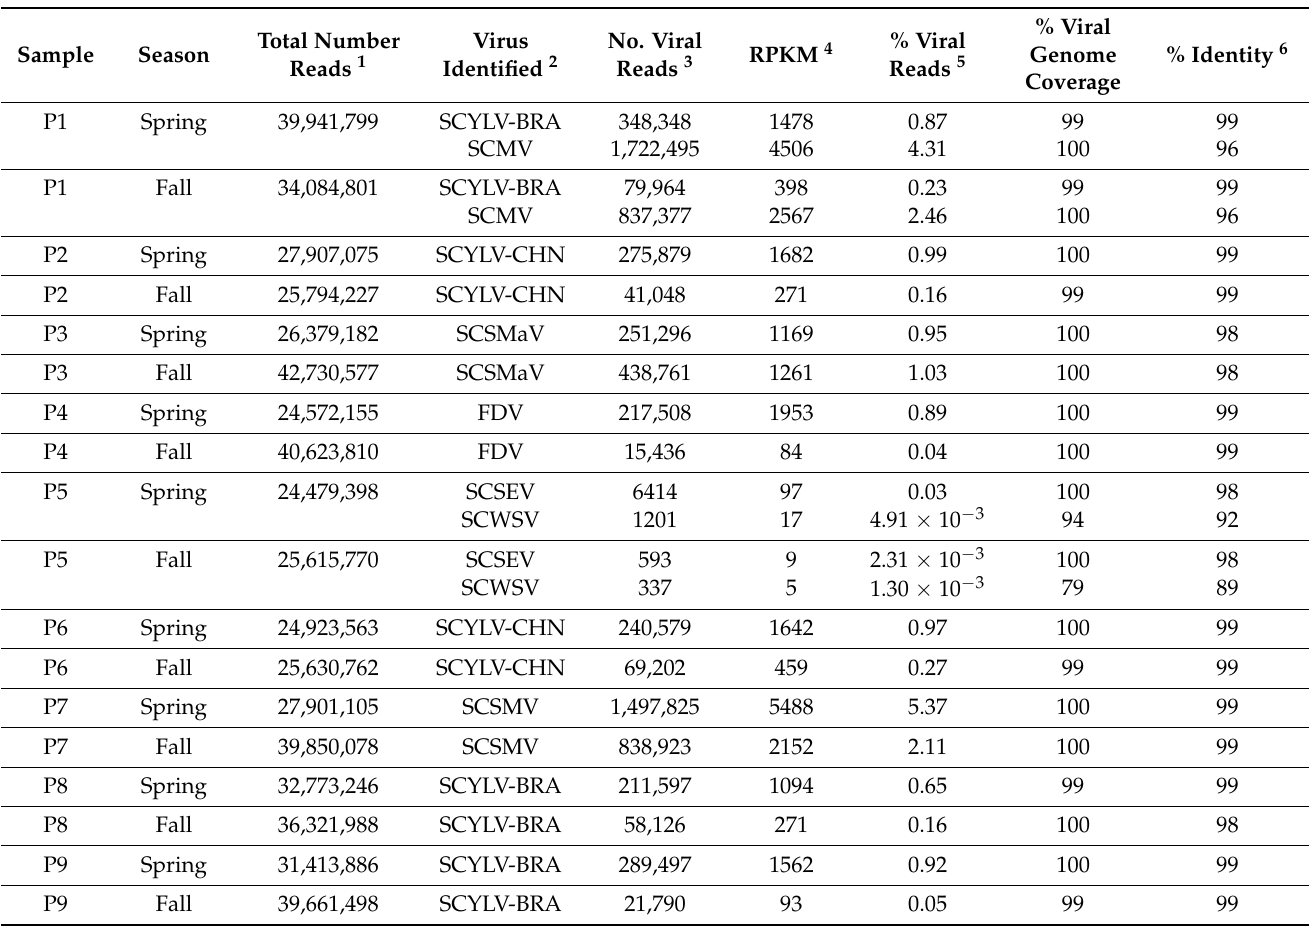
Table 3. Summary of sequencing and mapping statistics from HTS data generated for the nine sugarcane samples carrying various